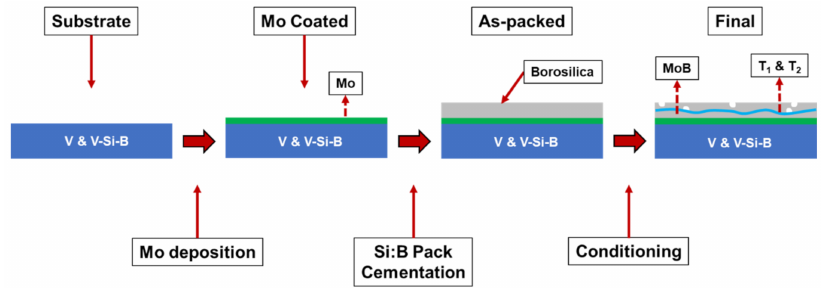
Figure 1. Schematic illustration of the coating process for pure vanadium and V-Si-B substrates.